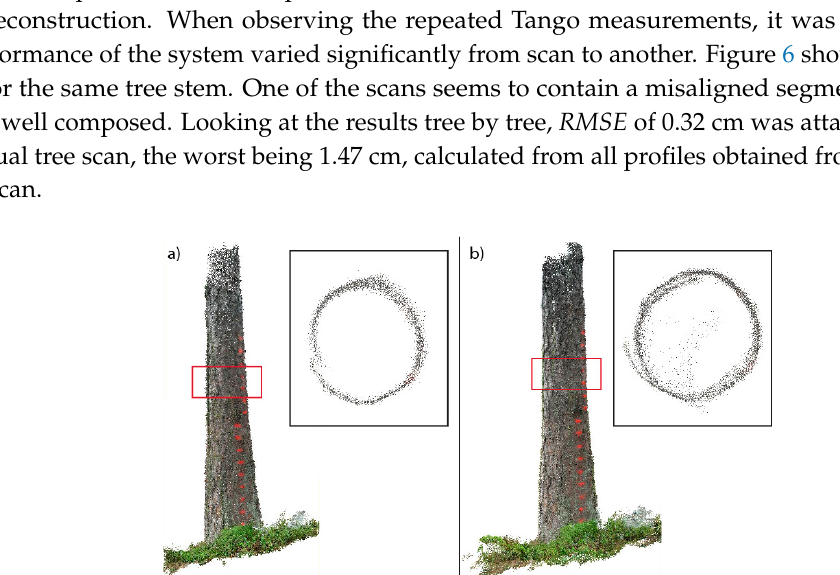
Figure 6. Misalignments of a tree stem segments from Tango device. The same tree scanned at two different points of time is shown in ( a , b ), respectively. The cross sections of marked areas are shown from a top-down view on the right. The misalignments can be seen in both scans, but the repeated scans at different points of time show different misalignments, which indicates the performance of the Tango system may clearly vary from scan to another.